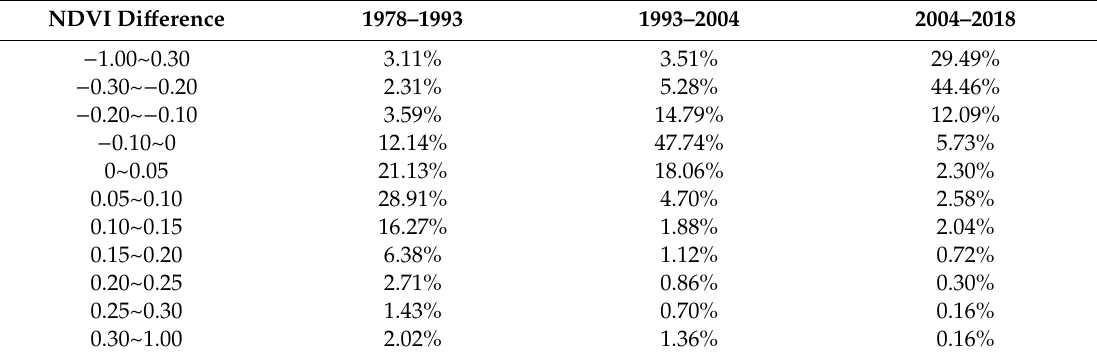
Table 5. Normalized Di ff erence Vegetation Index (NDVI) di ff erence of the Lanyang River Basin. NDVI Di ff erence